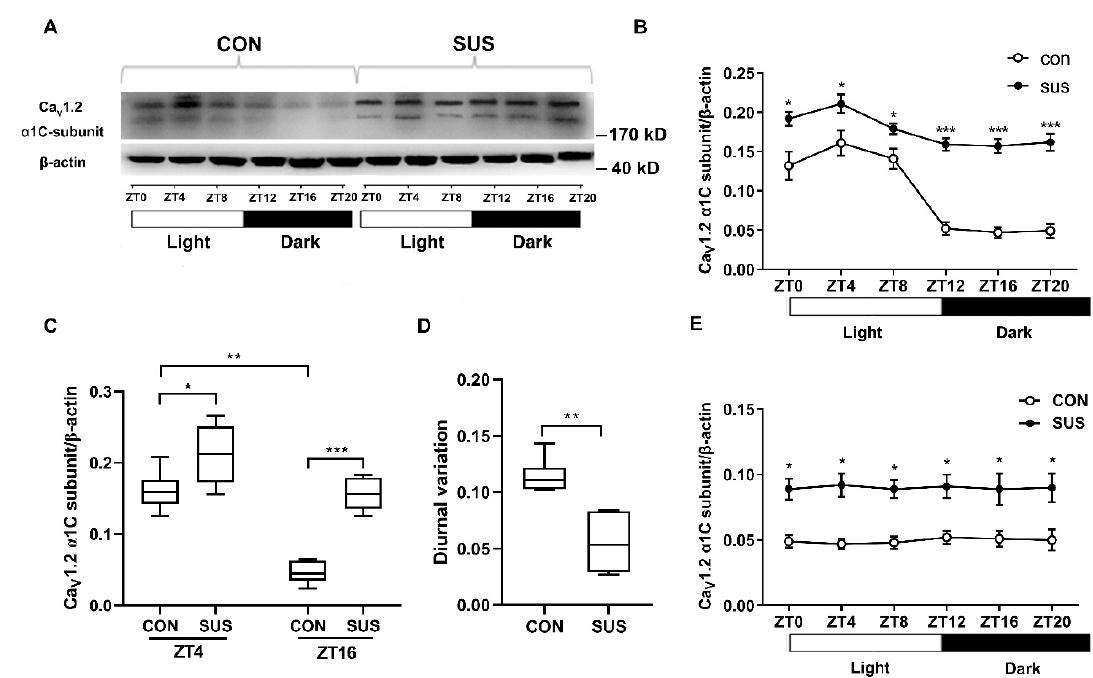
Figure 3. Circadian expression of Ca V 1.2 α 1C-subunit in cerebral arteries isolated from CON and SUS rats at six different time points. ( A ) The representative protein expressions of Ca V 1.2 α 1C-subunit are shown. ( B ) The mean data of protein expression display a circadian oscillation with the acrophase at subjective light-time and the trough at subjective dark-time. ( C ) The protein expression of Ca V 1.2 α 1C-subunit markedly increased at both ZT4 and ZT16 in SUS rats as compared with that in CON rats. ( D ) The diurnal variation in protein expression of Ca V 1.2 α 1C-subunit (the difference value between ZT4 and ZT16 level) significantly decreased in SUS rats as compared with that in CON rats. ( E ) both